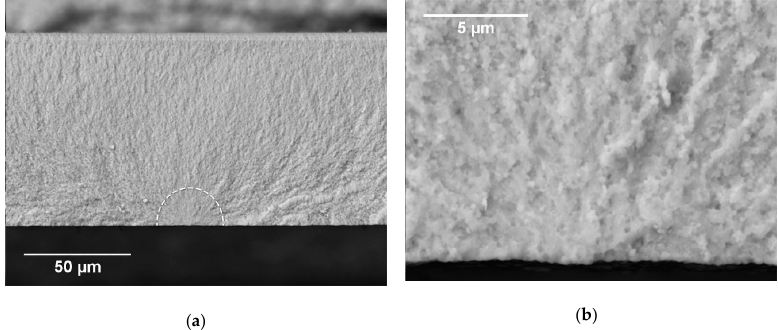
Figure 7. SEM images of the fracture surface of a 3YSZ specimen tested in B3B with the rough surface in tension. The dashed line in ( a ) highlights the fracture initiation site. ( b ) Magnified image of the initiation site.